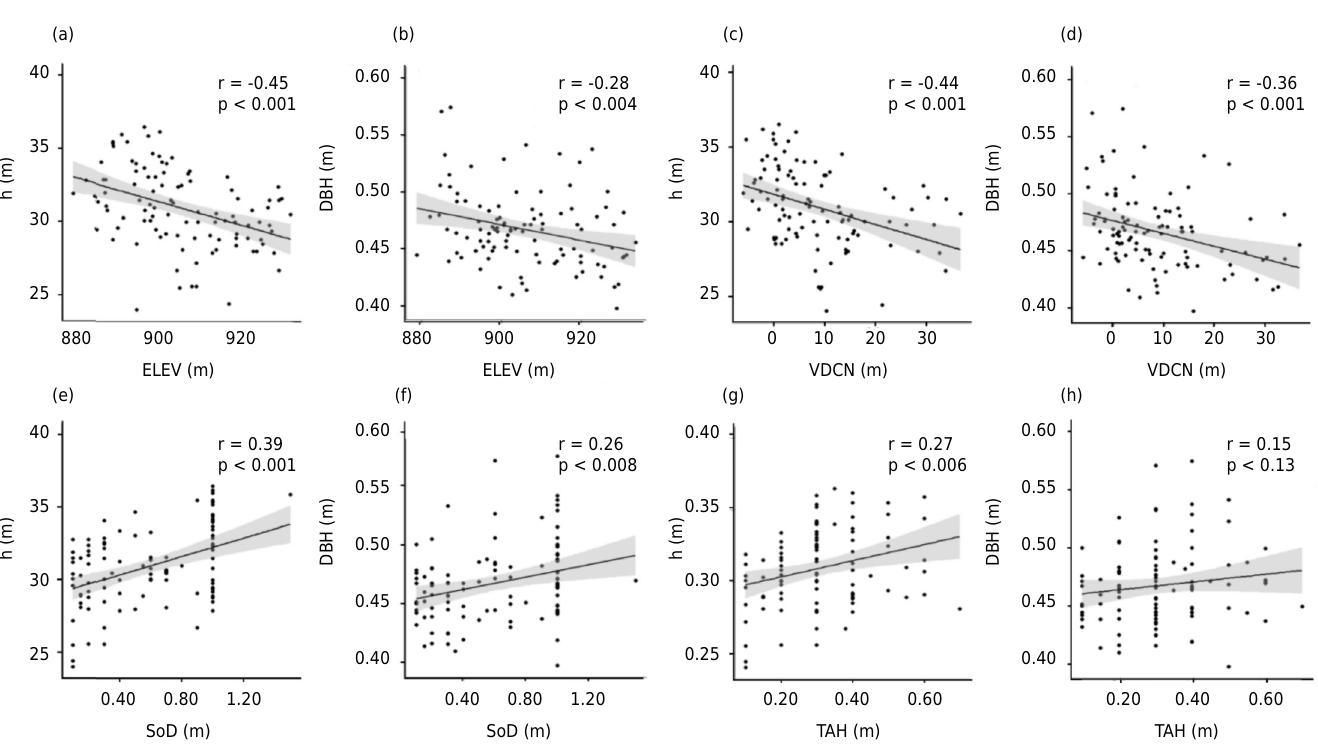
Figure 4. Significant Spearman’s correlation coefficients between dendrometric, topographic, and pedological variables of dataset 2, in which: h = total tree height; DBH = diameter at breast height; SLOPE = slope; ELEV = elevation; VDCN = vertical distance to channel network; SoD = solum depth; TAH = thickness of A